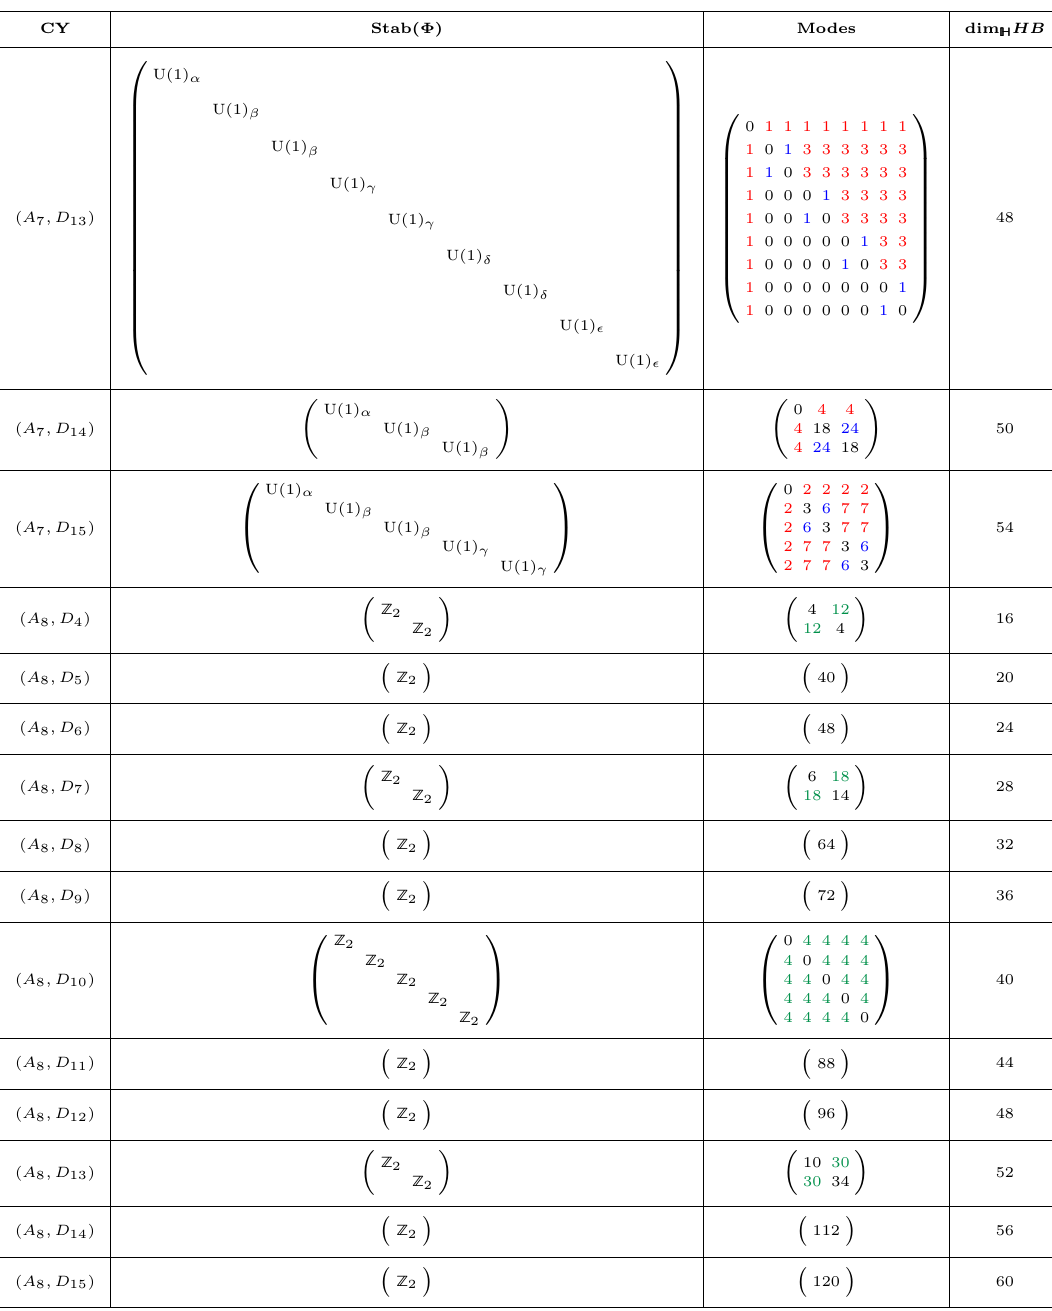
Table 6. Higgs branch data for ( A k , D n )